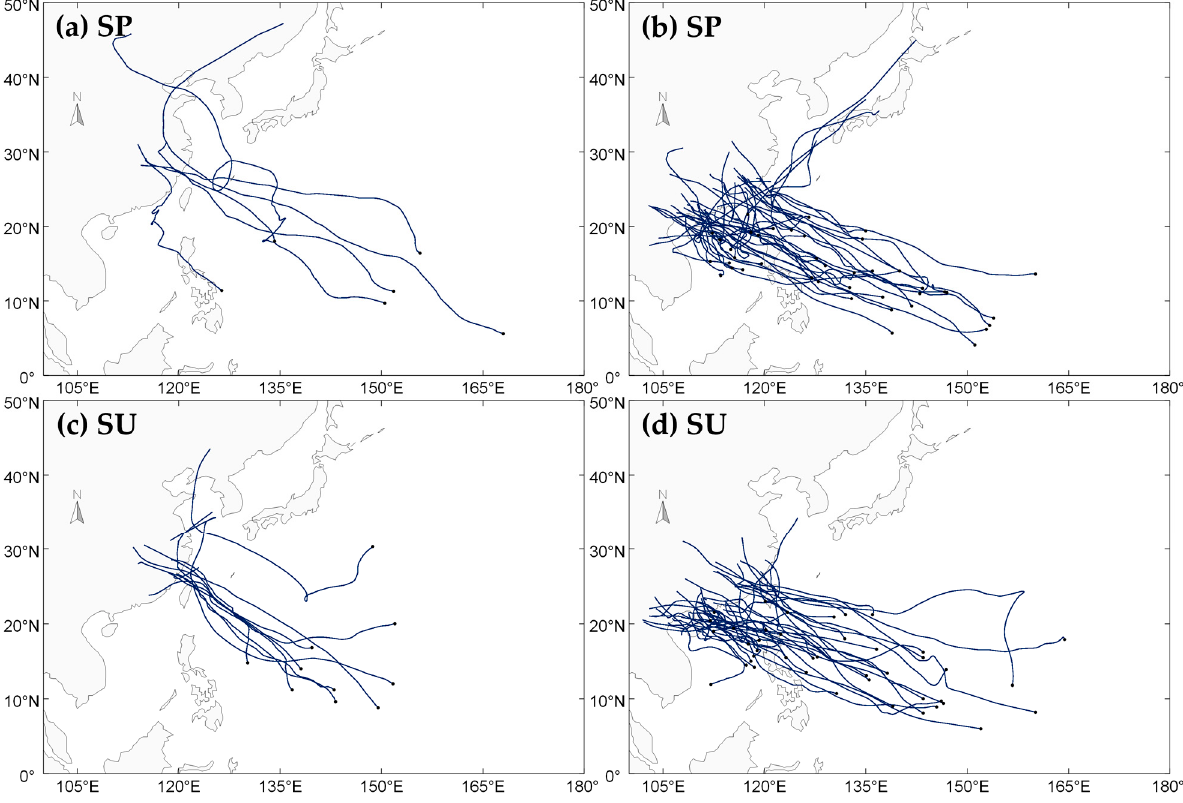
Figure 5. Same as Figure 4, but for TCs with different landfall locations (( a , c ) EC and ( b , d ) SC). According to the post-landfall statistics of TCs (Table 4), the average position of TC EC was signi fi cantly northwestward in SP El Niño years, whereas, for TCs that made landfall